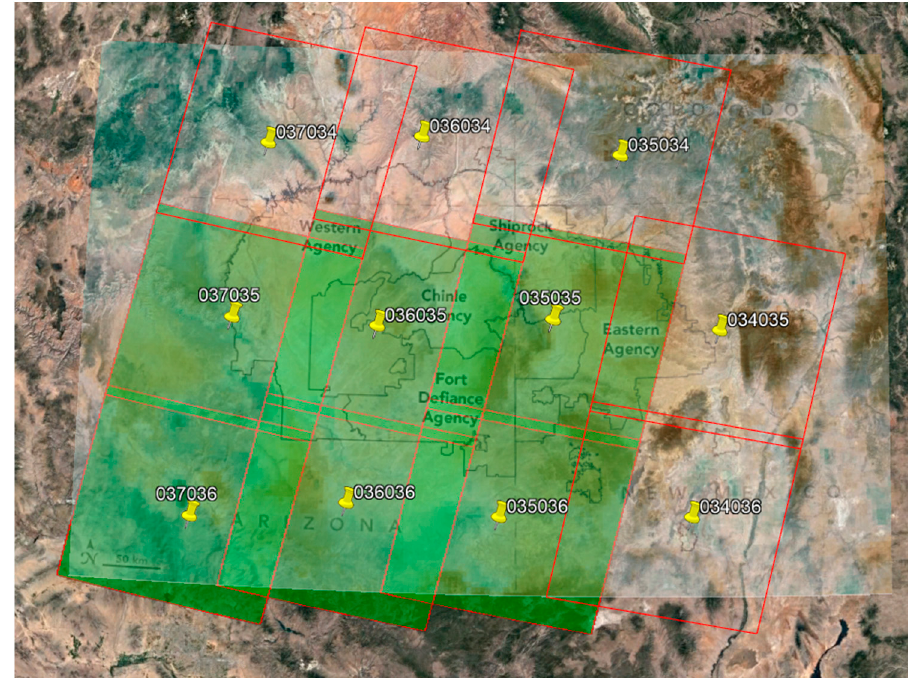
Figure 5. Image showing the extend of all 11 Landsat tiles outlined in red over the Navajo Nation in the northeastern corner of Arizona; only six Landsat scenes shaded in green with UTM labels overlay the riparian corridor ROI that was used in this study.